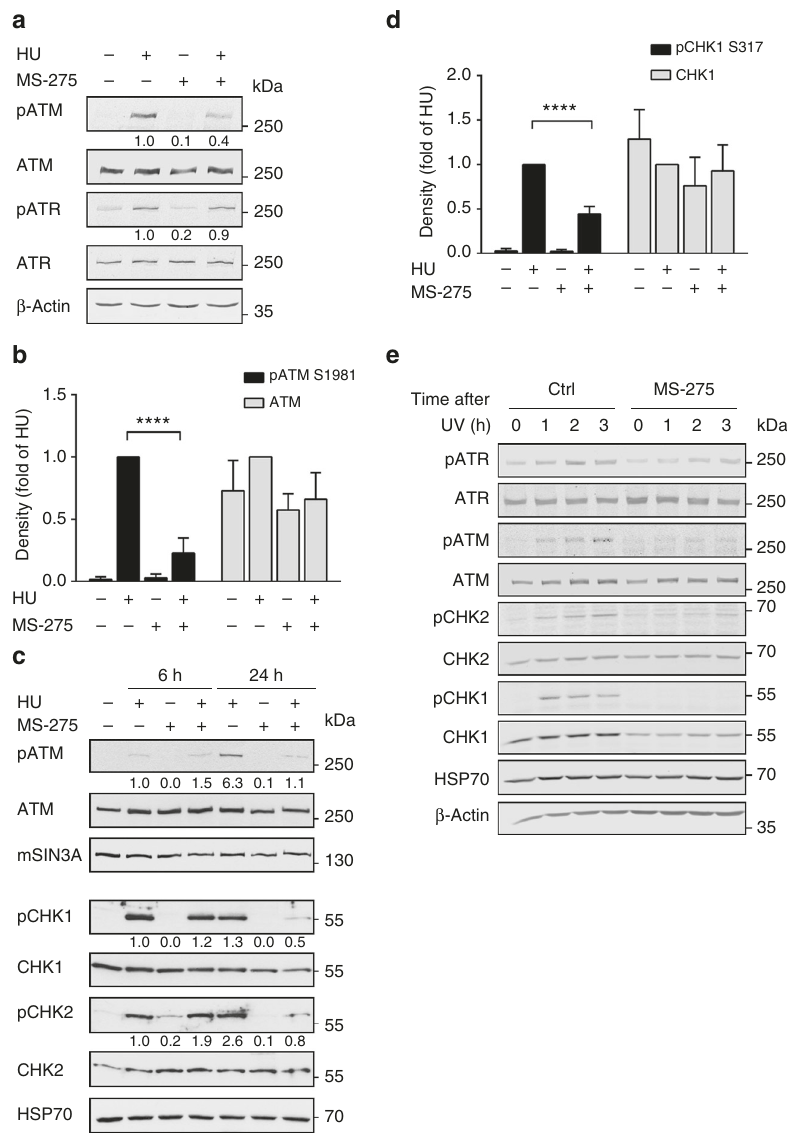
Fig. 1 HDACi impairs checkpoint signalling upon replicative stress. a HCT116 cells were stimulated with 1mM hydroxyurea (HU) and 2 µ M MS-275 for 24h. Western blot analyses of whole-cell lysates were performed to detect ATM and ATR as well as their phosphorylated forms (pATM S1981; pATR T1989). β -Actin served as loading control. Numbers indicate densitometric analysis of signals relative to HU-treated samples and normalised to β -Actin ( n = 3). b Densitometric evaluation of ATM phosphorylation at S1981 and ATM levels (after 24 h) following protein detection via immunoblot. Data were normalised to the loading controls. The respective amounts (phosphorylated) proteins are compared to those of HU-treated cells. Results represent the mean ± SD ( n = 3; one-way ANOVA; **** P < 0.0001). c Cells were treated with 1 mM HU and 2 µ M MS-275 for 6-24 h. Whole-cell extracts were blotted to two membranes to detect phosphorylated and total levels of ATM, CHK1 (pCHK1 S317) and CHK2 (pCHK2 T68) by immunoblot. HSP70 and mSIN3A are loading controls. Numbers indicate densitometric analysis of signal relative to HU-treated cells and normalised to the respective loading control ( n = 3). d Densitometric analysis of phosphorylated (S317) and total CHK1 levels after 24 h detected via western blot. Data were normalised to the respective loading controls. Results display relative amounts of pCHK1/CHK1 compared to HU-treated cells as mean ± SD ( n = 3). Statistical analysis was performed using one-way ANOVA (**** P < 0.0001). e Cells were either pre-incubated with 2 µ M MS-275 or were left untreated for 24 h and subsequently exposed to 10 J/m 2 UVC. Plates were harvested 0, 1, 2 and 3 h after irradiation. Indicated proteins were detected via western blot. HSP70 and β -Actin served as loading